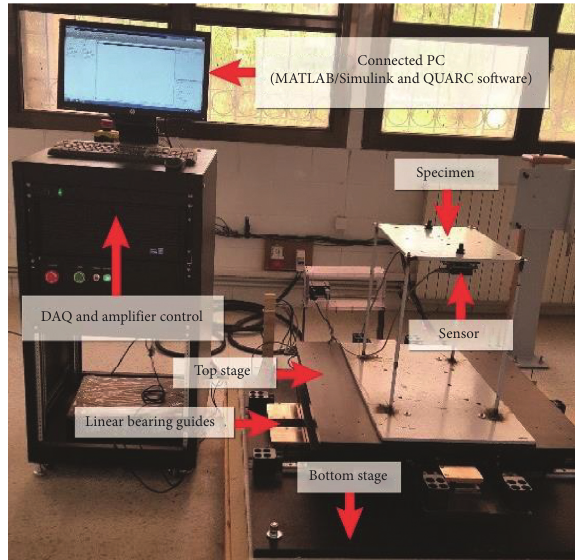
Figure 1: Experimental setup of biaxial electric QUANSER